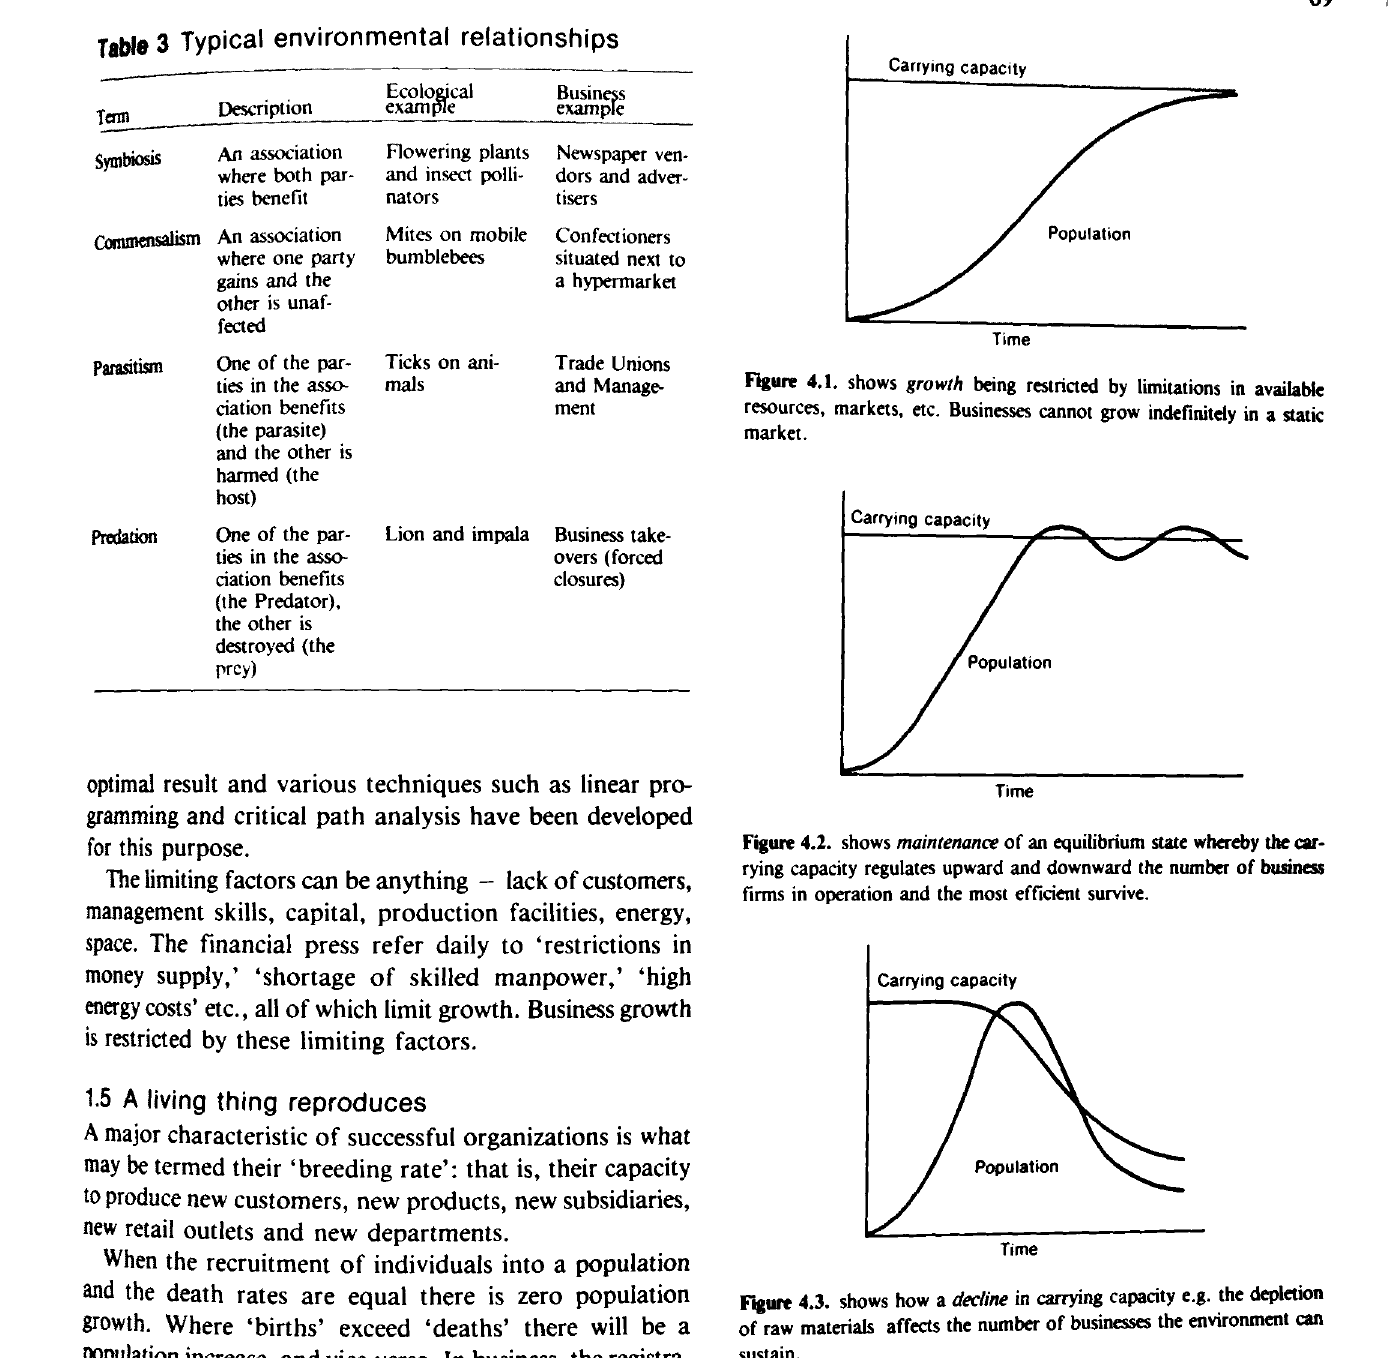
Table 3 Typical environmental relationships Term